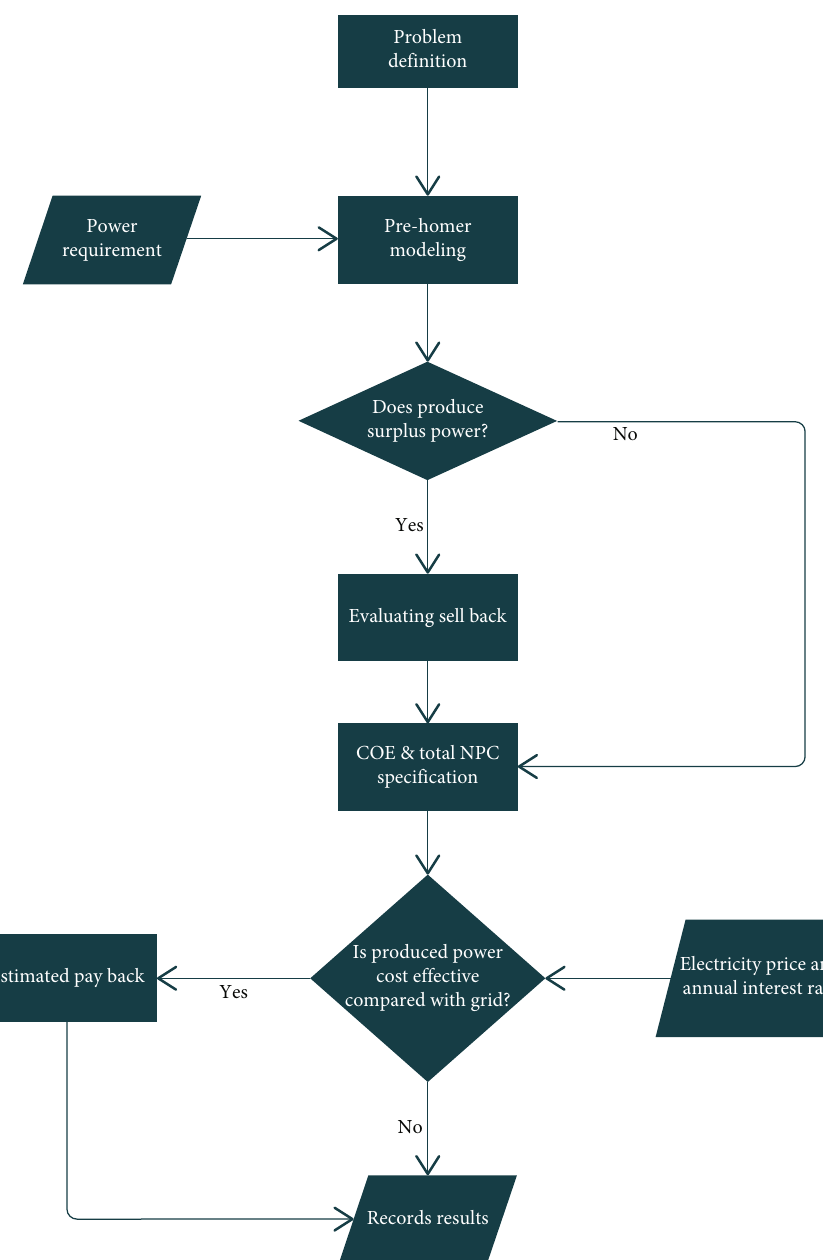
Figure 3: Flowchart of present work